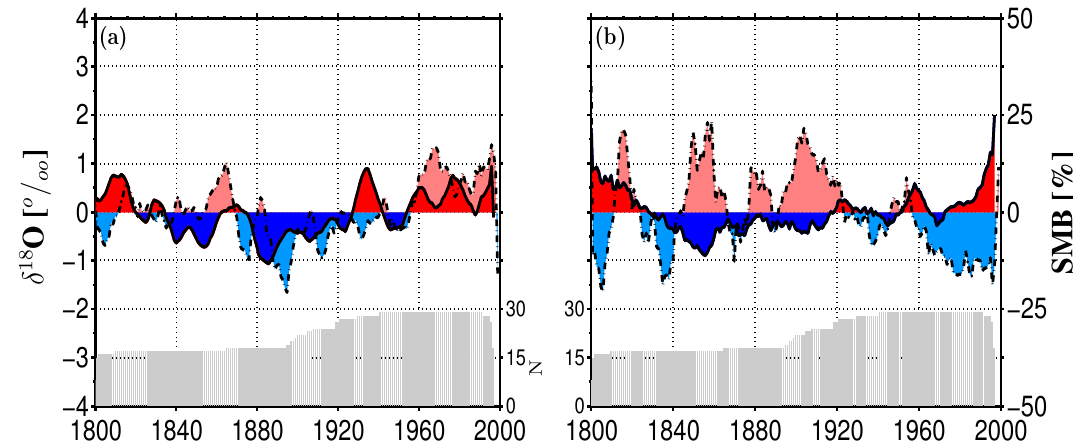
Figure 8. Composite records (11-year moving average) of (a) δ 18 O as deviation from the mean (‰) and (b) SMB as deviation from the mean (%) for the plateau (solid line) and coastal region (dashed) for the last 2 centuries. The grey bars indicate the number of cores that contribute to the composite record of the plateau. The ice shelf record consists only of S100 and B04. Shading: time periods with positive (red) and negative (blue) deviations from the mean.